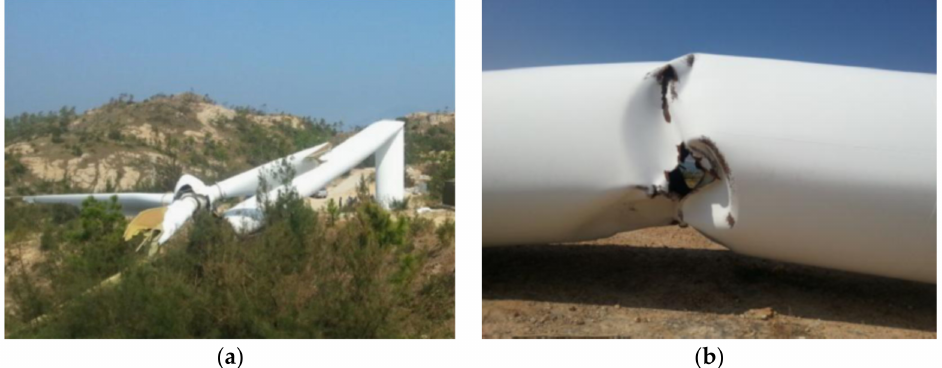
Figure 4. Photographs displaying tower damage due to Typhoon Usagi [23]: ( a ) tower collapse; ( b ) buckling